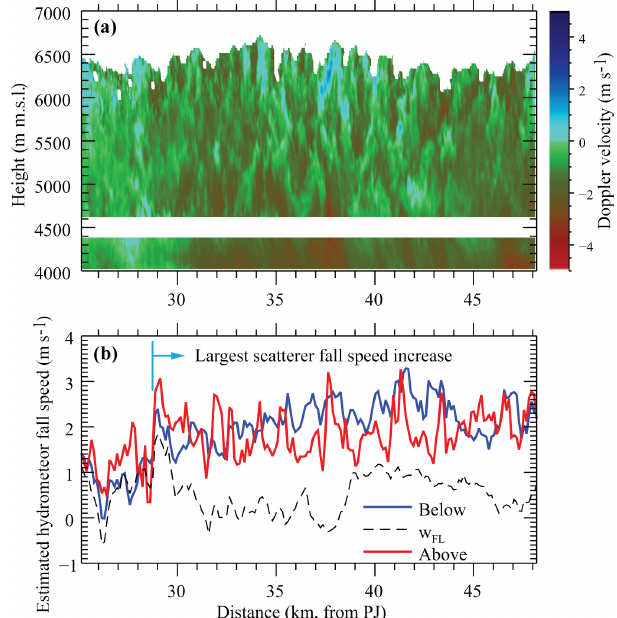
Figure 7. Doppler velocity and estimated hydrometeor terminal fall speed for a portion of leg 1. Vertical cross section of Doppler veloc- ity (a) and reflectivity-weighted hydrometeor population terminal fall speed (b) estimated by flight level gust probe vertical velocity (dashed black) minus averaged Doppler velocity of the three nearest useable radar gates above (red) and below (blue) flight